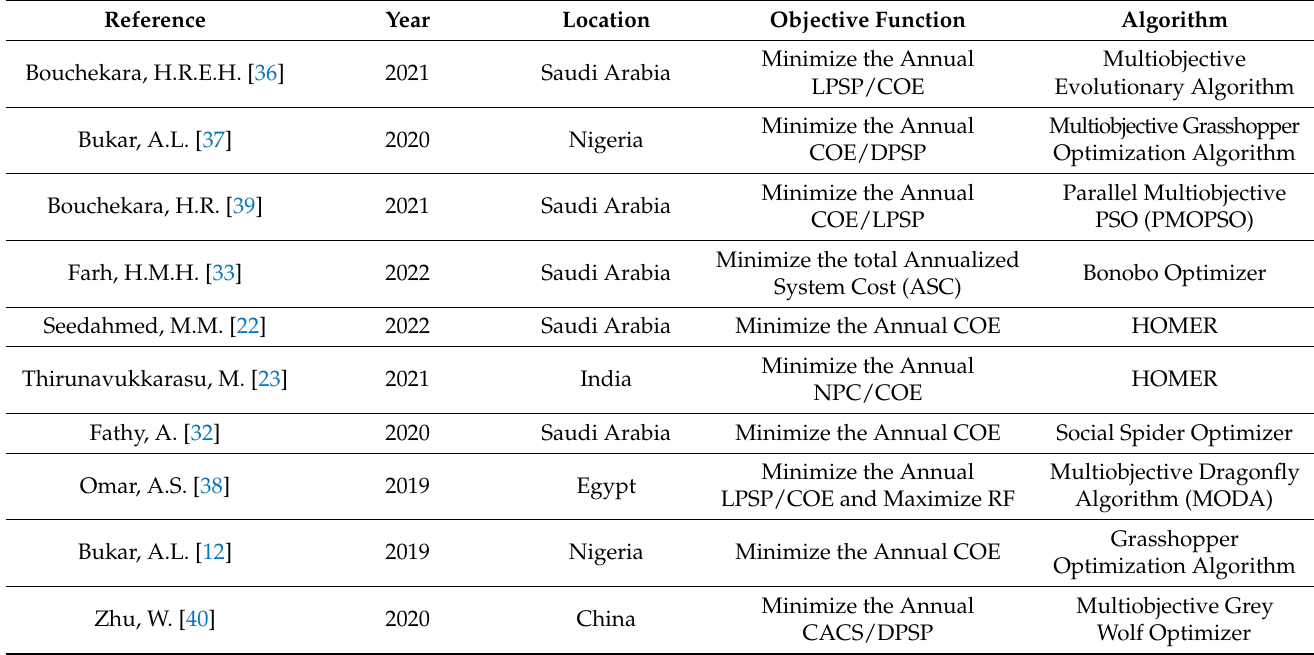
Table 1. Summary of reported methods in optimizing